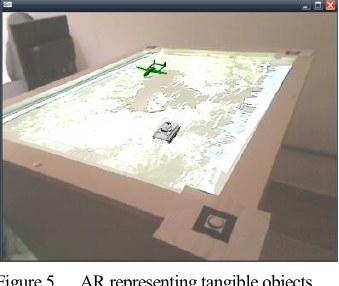
Figure 5. AR representing tangible objects.